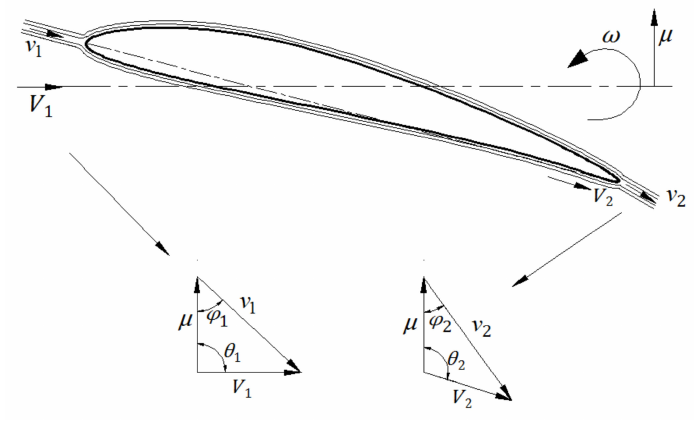
Figure 6. Velocity diagram at the inlet and outlet.